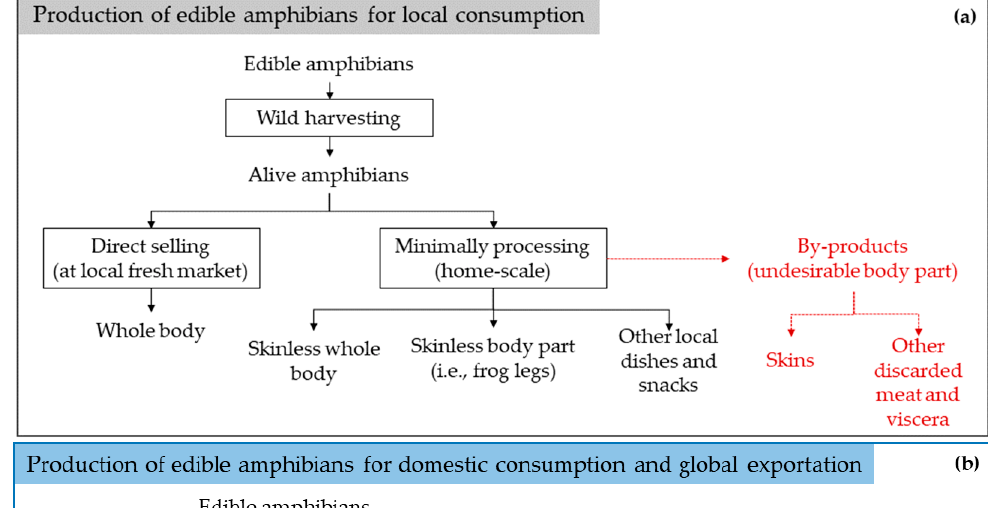
obtained as less processing steps are involved. This is in contrast with those for domestic and global exportation (Figure 1b).